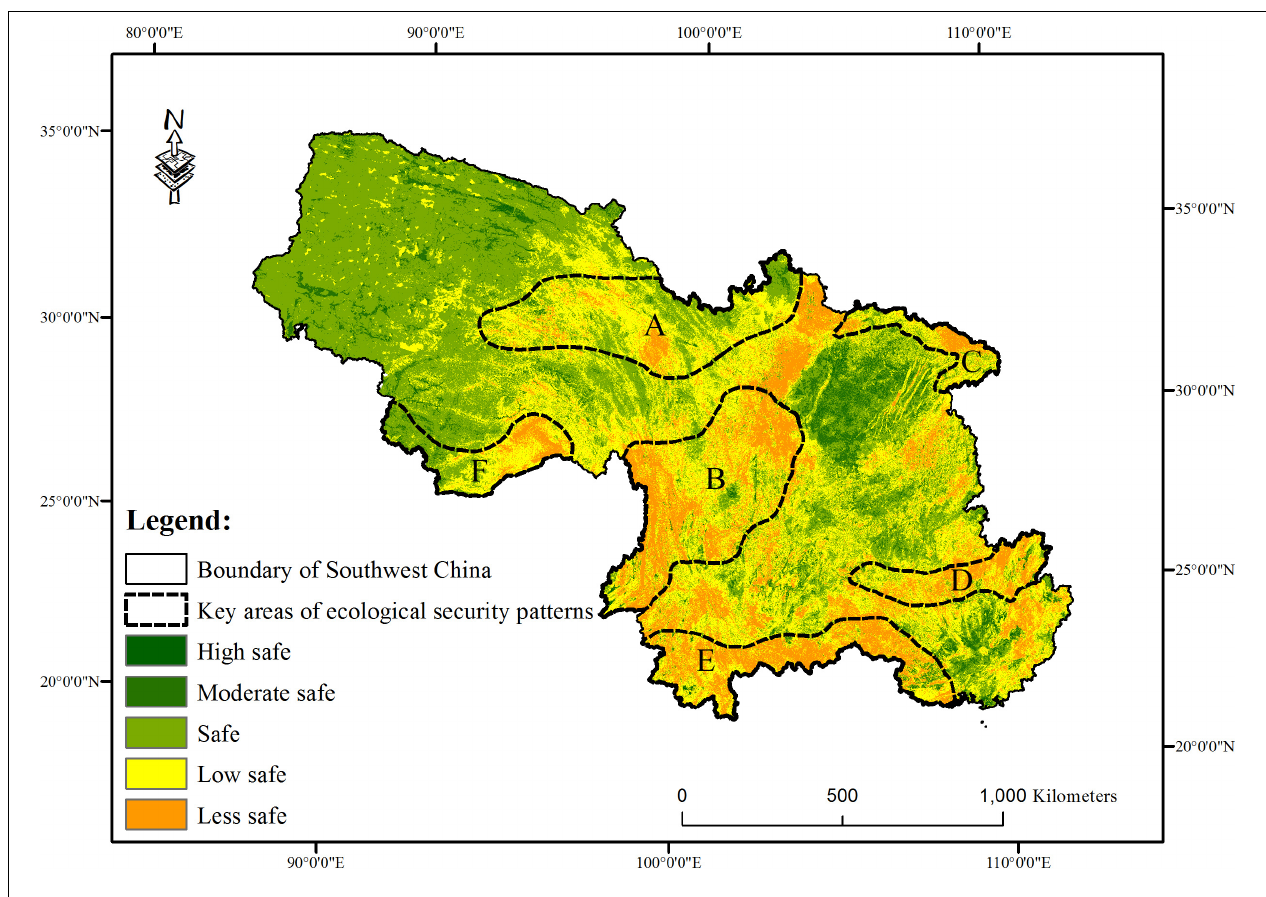
FIGURE 6 | Distributions of the ESs-based ESPs in Southwest China.